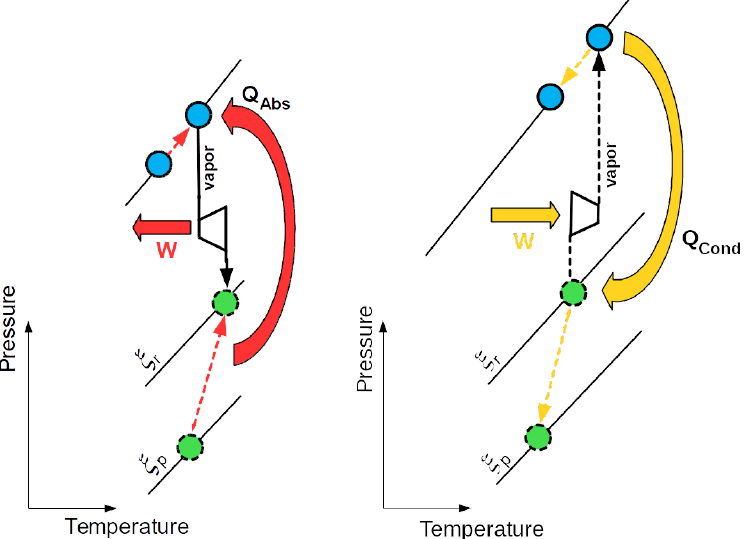
Figure 2. Mechanical discharging phase ( left ) and mechanical charging phase ( right ) [43].